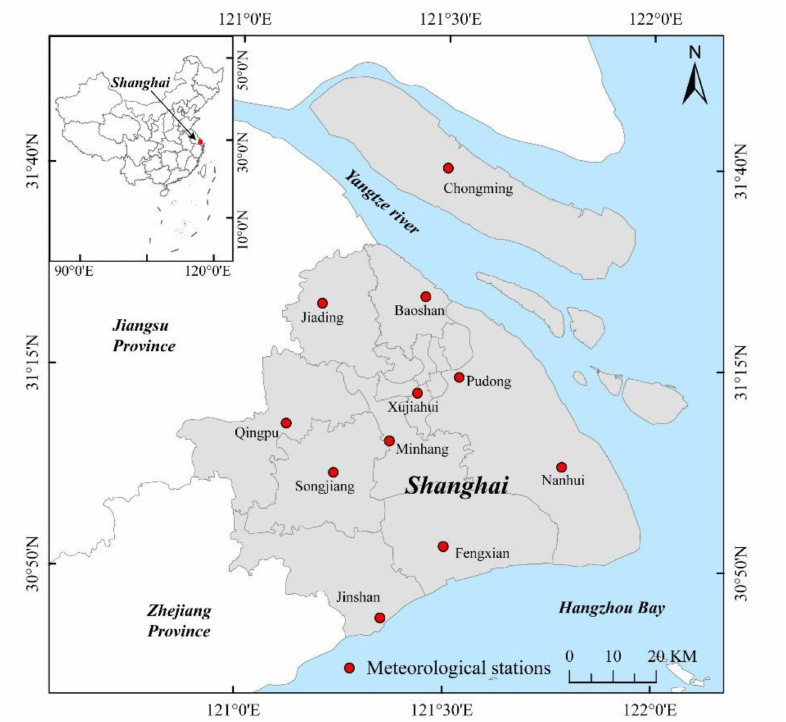
Figure 1. The location of the study area and meteorological